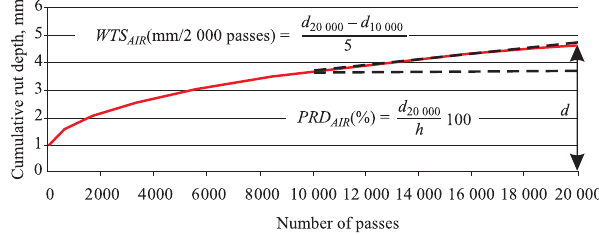
Fig. 4. Typical rutting test results